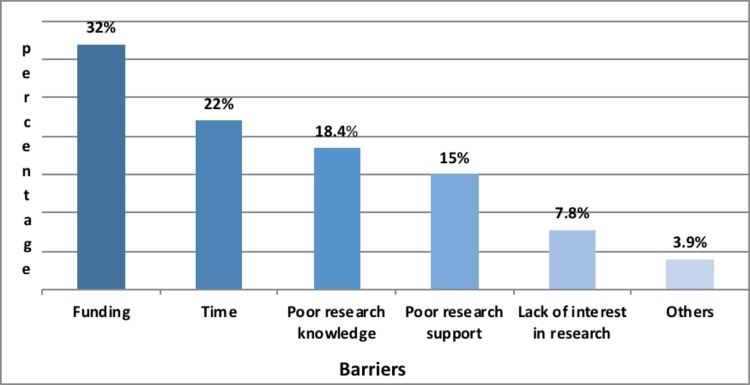
Research barriers.